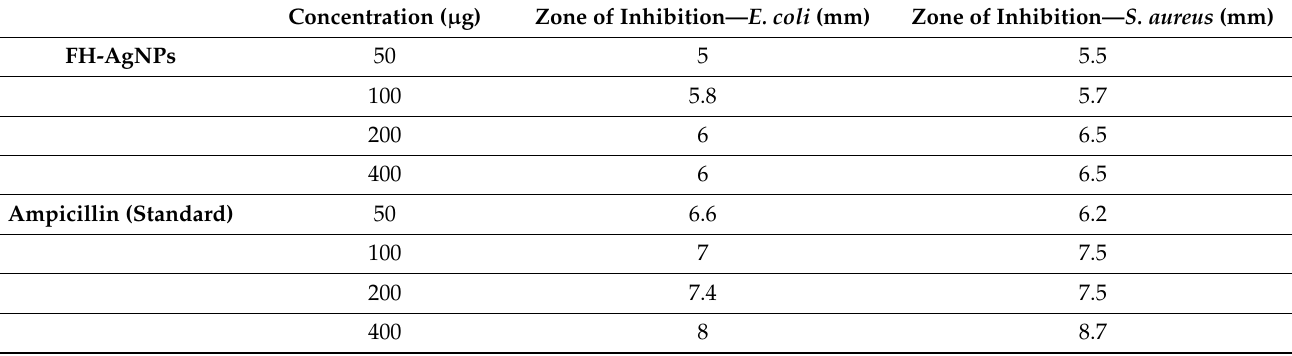
Table 1. Antimicrobial studies of FH-AgNPs against E coli and S. aureus. Concentration ( µ g) Zone of Inhibition— E. coli